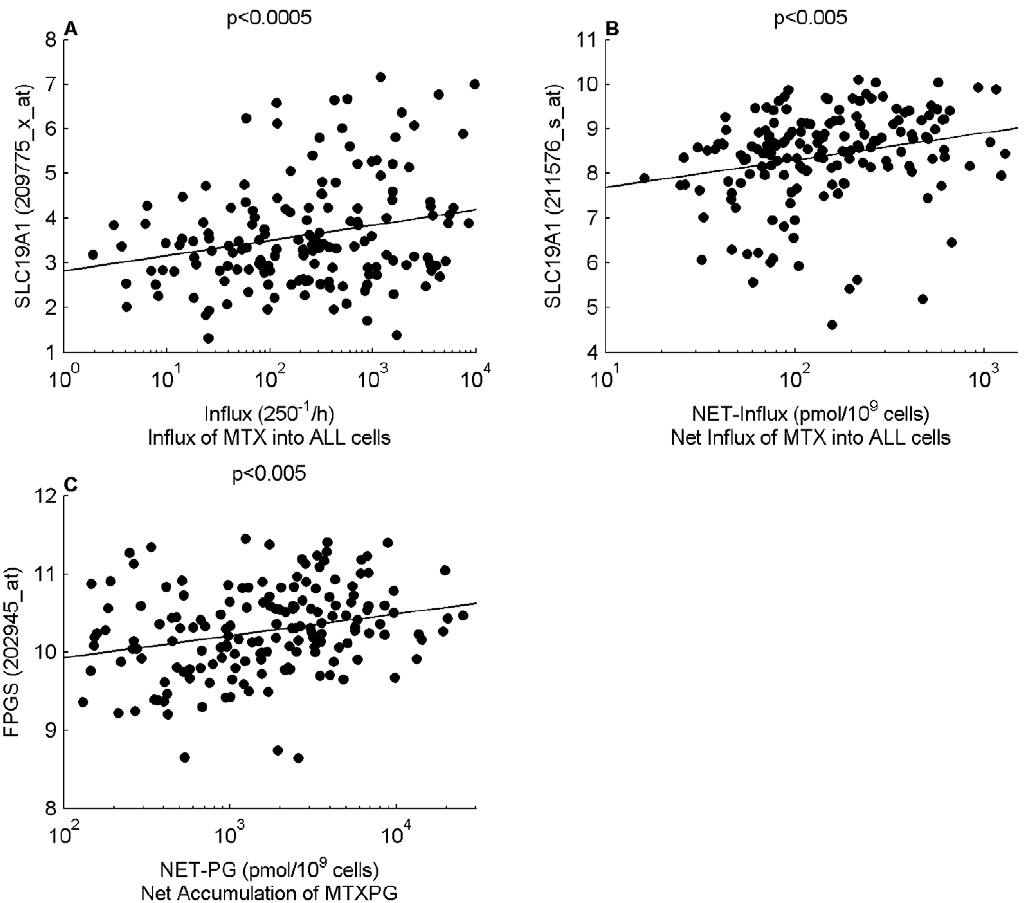
Figure 4. MTXPG model parameters vs gene expression in ALL blasts at diagnosis. ( A ) SLC19A1 expression (Probe Set ID: 209775_x_at) vs Influx. ( B ) SLC19A1 (Probe Set ID: 211576_s_at) vs NET-influx. ( C ) FPGS expression (Probe Set ID: 202945_at) vs NET-PG.